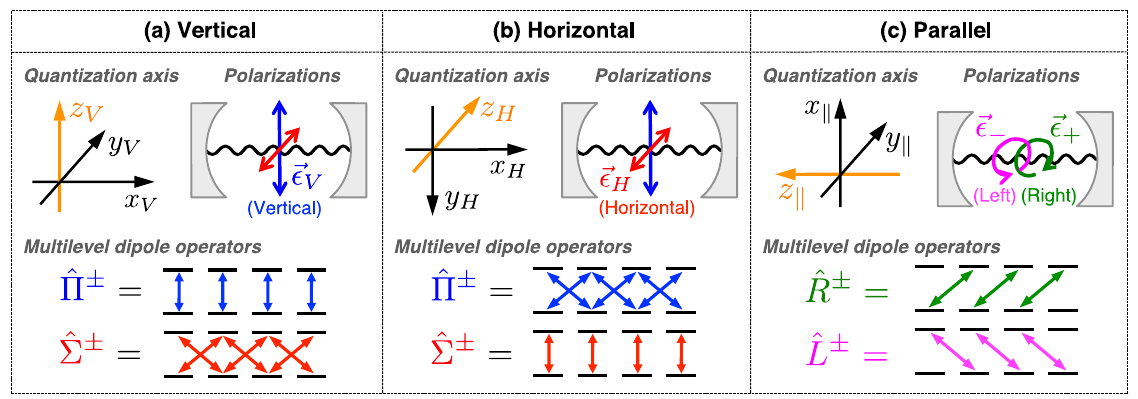
; ˆ y ; ˆ z with quantization axis ˆ z , (ii) the typical cavity- q q q g q and j β i is connected by a colored arrow. The operators in panel (a) correspond to q q